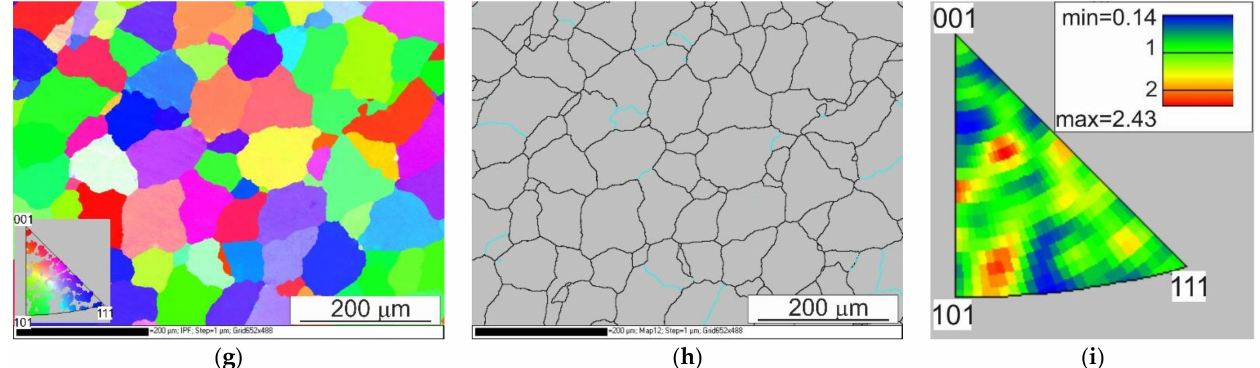
Figure 23. EBSD analysis results of the sample after homogenisation; ( a,b,c ) centre of the sample, ( d,e,f ) distance from the centre = 0.67 r, ( g,h,i ) distance of the centre = 0.72 r; ( a,d,g ) EBSD maps showing changes in orientation, ( b,e,h ) maps showing the types of edges (the edges of a large angle are marked in black, and the edges of a small angle are marked in blue) and a ( c,f,i ) basic triangle—orientation intensity.